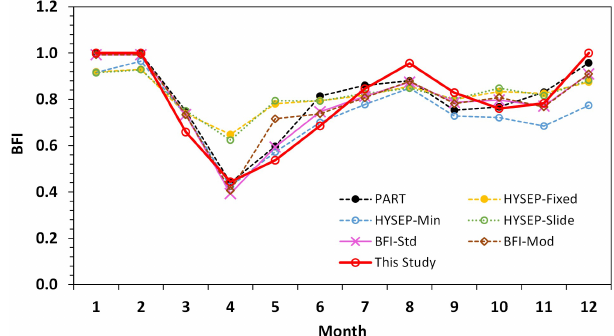
Figure 10. Baseflow index (BFI) estimated by different methods for the Albany River. Data shown are calculated using the 15 year (2002–2016) means of baseflow and